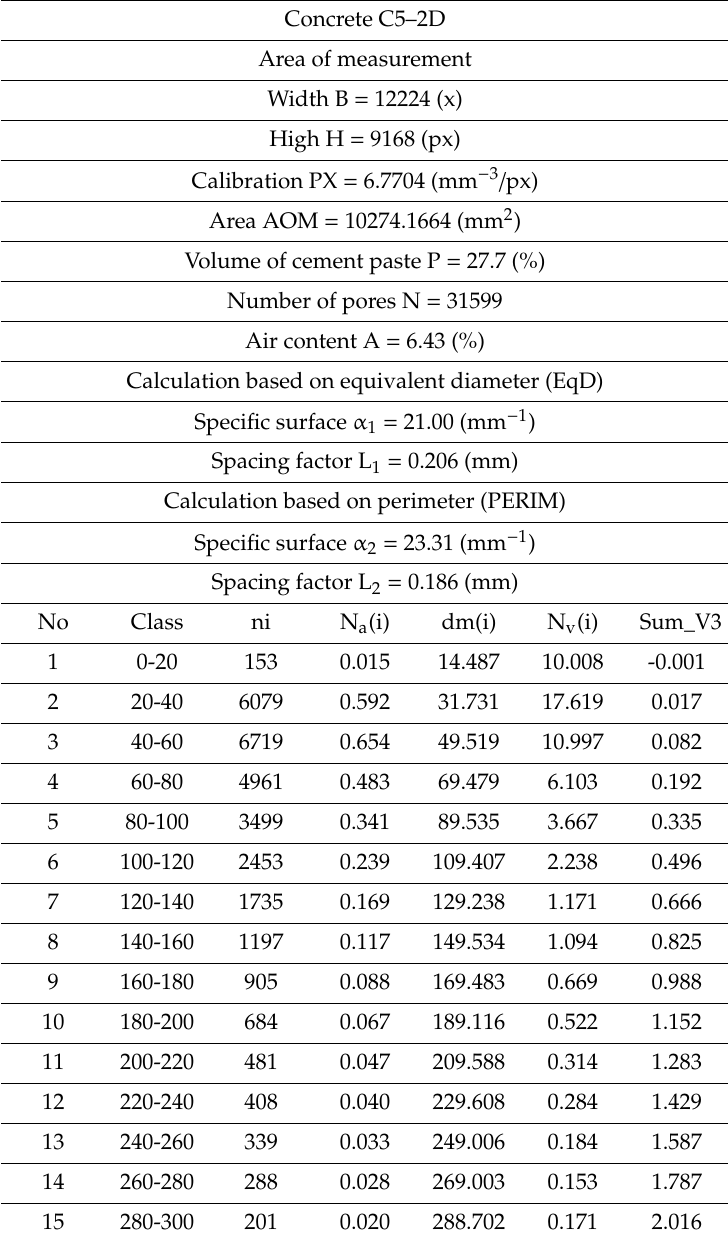
Table 1. Results of calculations with the use of the VBA macro in MS